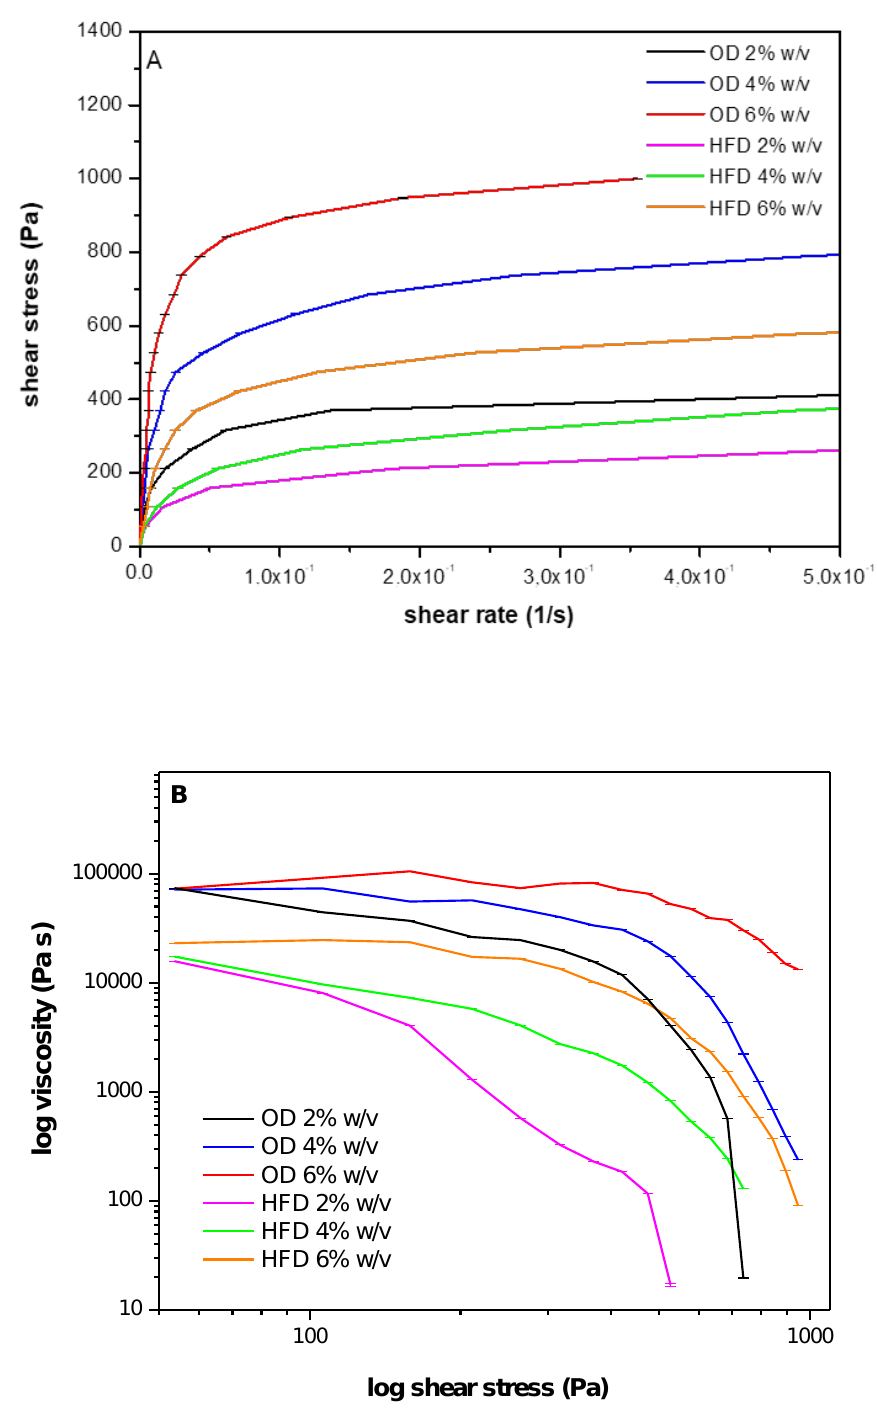
Figure 4. ( A ) Plot of Shear stress (Pa) as a function of shear rate (s − 1 ) and ( B ) plot of log viscosity (Pa · s) as a function of log shear stress (Pa). registered at 25 ◦ C of hydrogels obtained from OD and HFD samples using three different percentages (2, 4 and 6% w/v ), n = 3, the bars represent the SD. As reported in literature, AP contains polysaccharides such as pectins [26,29,30], typical components of plant cell wall, containing mainly arabinose (58 mol%), galacturonic acid (16 mol%) and glucose (10 mol%) to which could be attributed the thickening capacity. Differences can be detected between the samples obtained from OD and HFD. Com- paring hydrogels obtained using the same AP percentages, the sample OD showed a higher thickening capacity than HFD. This can be easily explained comparing the shear